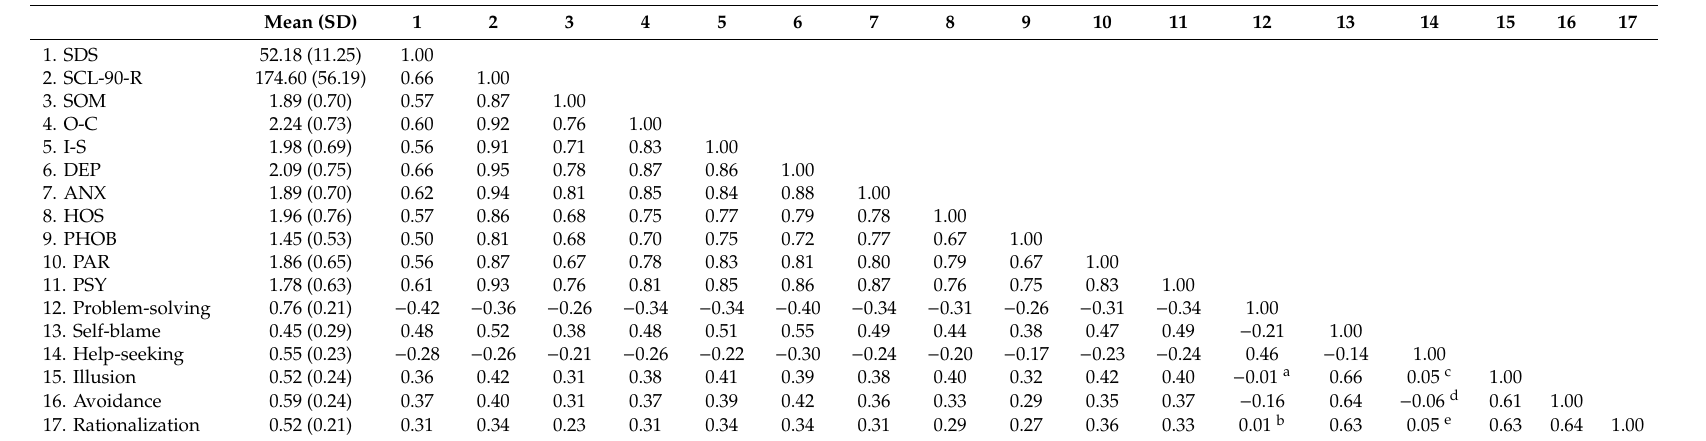
Table 1. Descriptive statistics and correlation